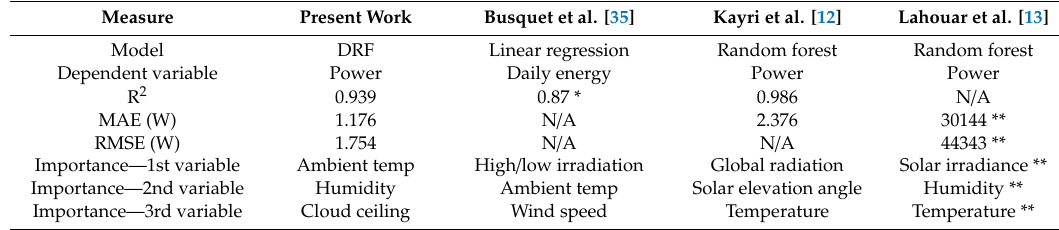
Table 7. Comparison with recent